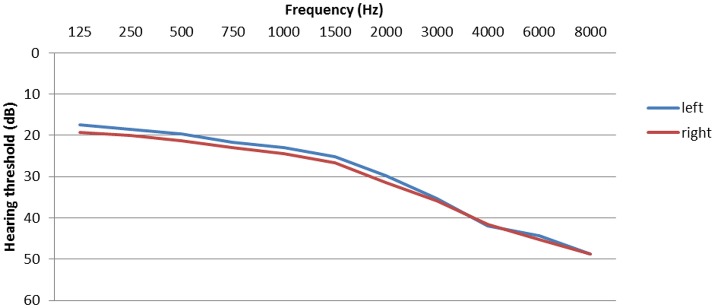
Hearing thresholds.